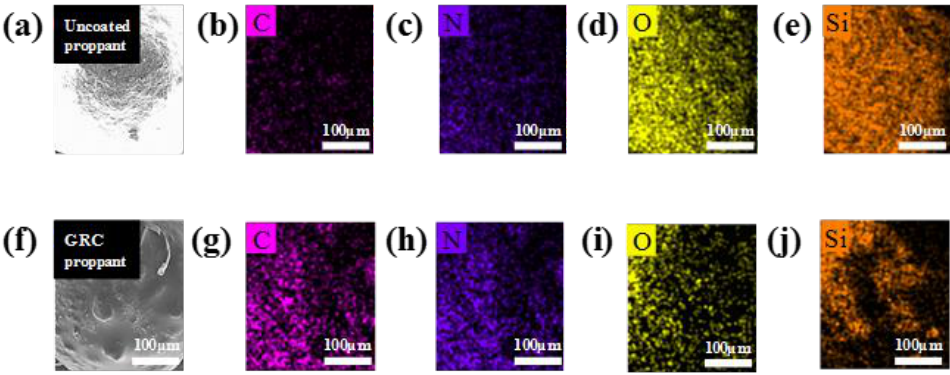
Figure 3. EDX mapping of uncoated ( a – e ) and GRC ( f – j ) proppants.